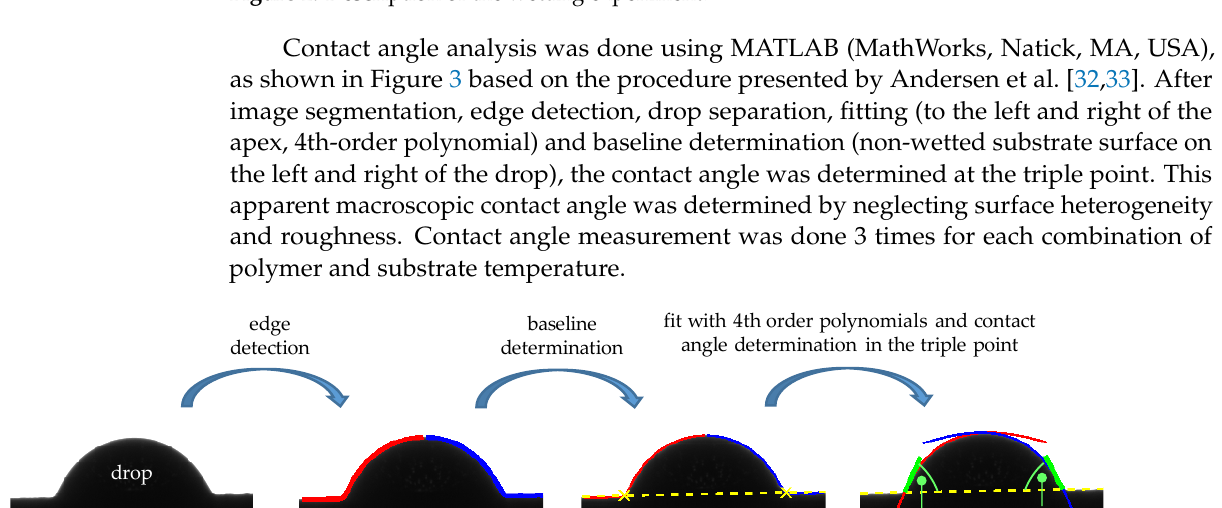
l , and right, ϕ r , contact